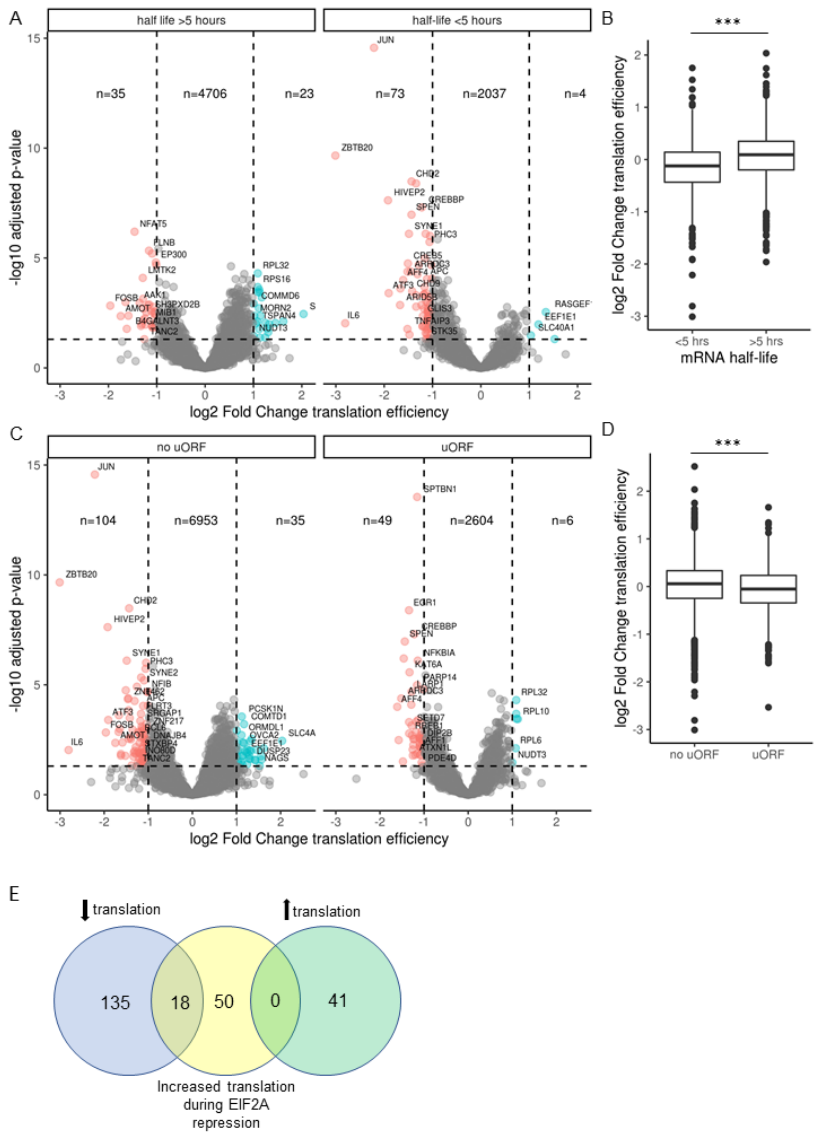
Figure 6. mRNA features influence sensitivity to translation inhibition. ( A ) Volcano plot showing global translation efficiency (Riborex engine) changes of 6878 genes in SARS-CoV-2 infected Calu-3 cells with previously documented mRNA stability [22]. Log2FoldChange infected 24 h versus mock. 135 transcripts were differentially expressed (DE) in SARS-CoV-2 infected cells based on the cut-off of p -value < 0.05, log2fold change > 1. Genes were categorized as having half-life more or less than 5 h as indicated. ( B ) Log2 fold change as presented in ( A ) of unstable (<5 h mRNA half-life) and stable (>5 h mRNA half-life) genes presented using geom_boxplot function in the ggplot2 R package using the 25th and 75th percentiles to form the box and whiskers no larger than 1.5 times the interquartile range. Data points beyond the whiskers are outliers. *** indicates one-way analysis of variance [ANOVA], p < 0.001. ( C ) Volcano plot showing global translation efficiency changes of 9751 genes in SARS-CoV-2 infected Calu-3 cells, 2659 of which have one or more high-confidence upstream open reading frames (uORFS) obtained from [26]. ( D ) Log2 fold change for genes with no uORF or one or more uORF as presented in ( C ) using geom_boxplot as described in ( B ). *** indicates one-way analysis of variance [ANOVA], p < 0.001. ( E ) Venn diagram showing genes significantly decreased in translation efficiency by 24 h of SARS-CoV-2 infection in Calu-3 cells (blue), genes increased in translation during EIF2A repression [25] (yellow) and genes significantly increased in translation efficiency by 24 h of SARS-CoV-2 infection in Calu-3 cells (green).